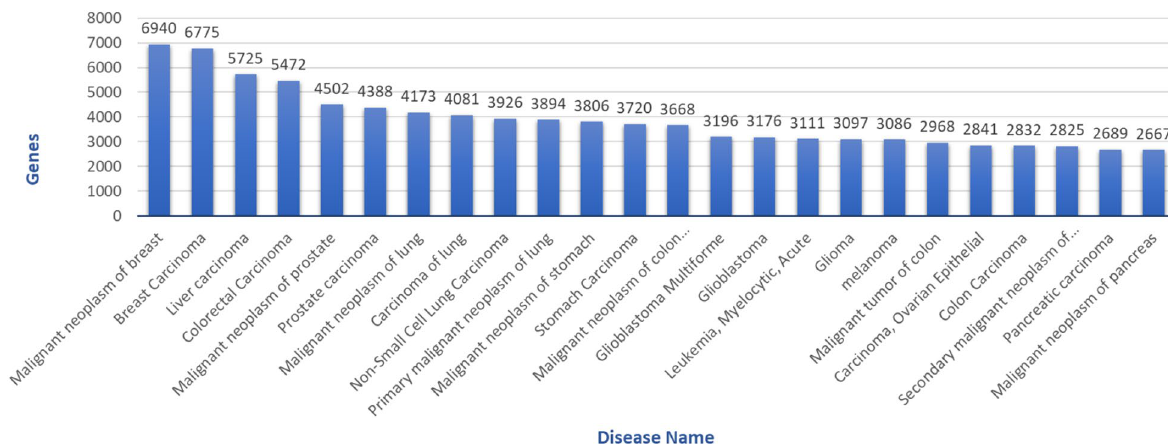
Figure 1. A part of the DisGeNET dataset histogram frequency plot. It shows the number of genes associated with each disease, where the X-axis is the disease name, and Y-axis is the number of